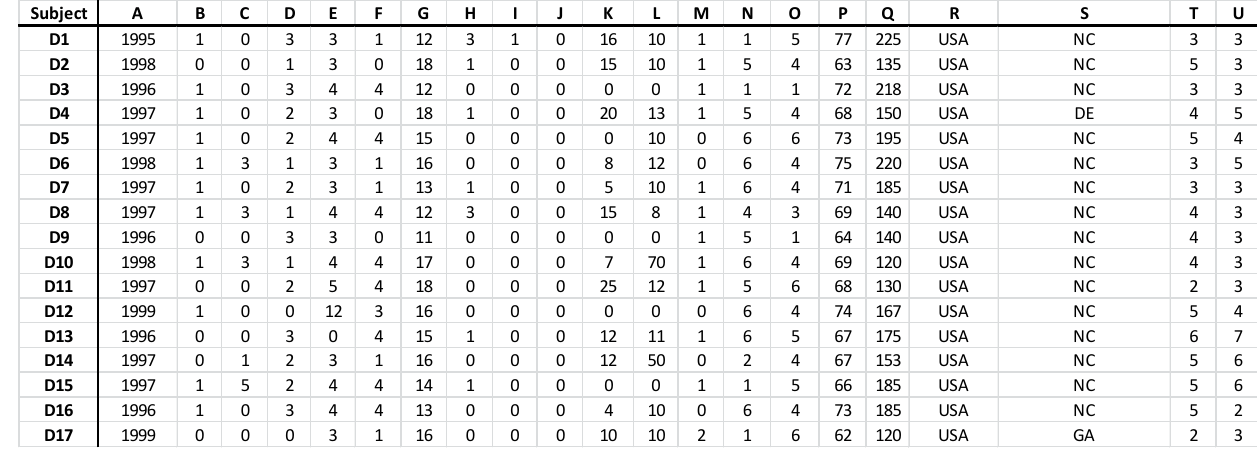
Figure A16. Individual Demographic Data—Session D.